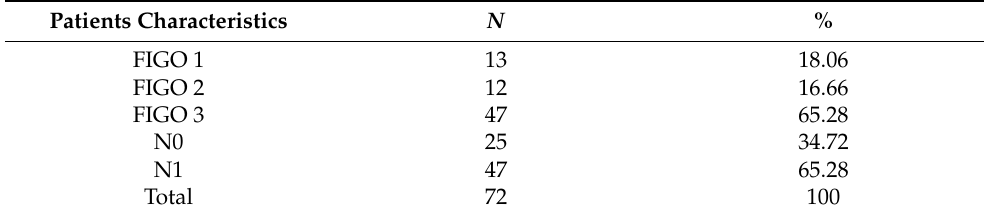
Table 1. Characteristics of patients.